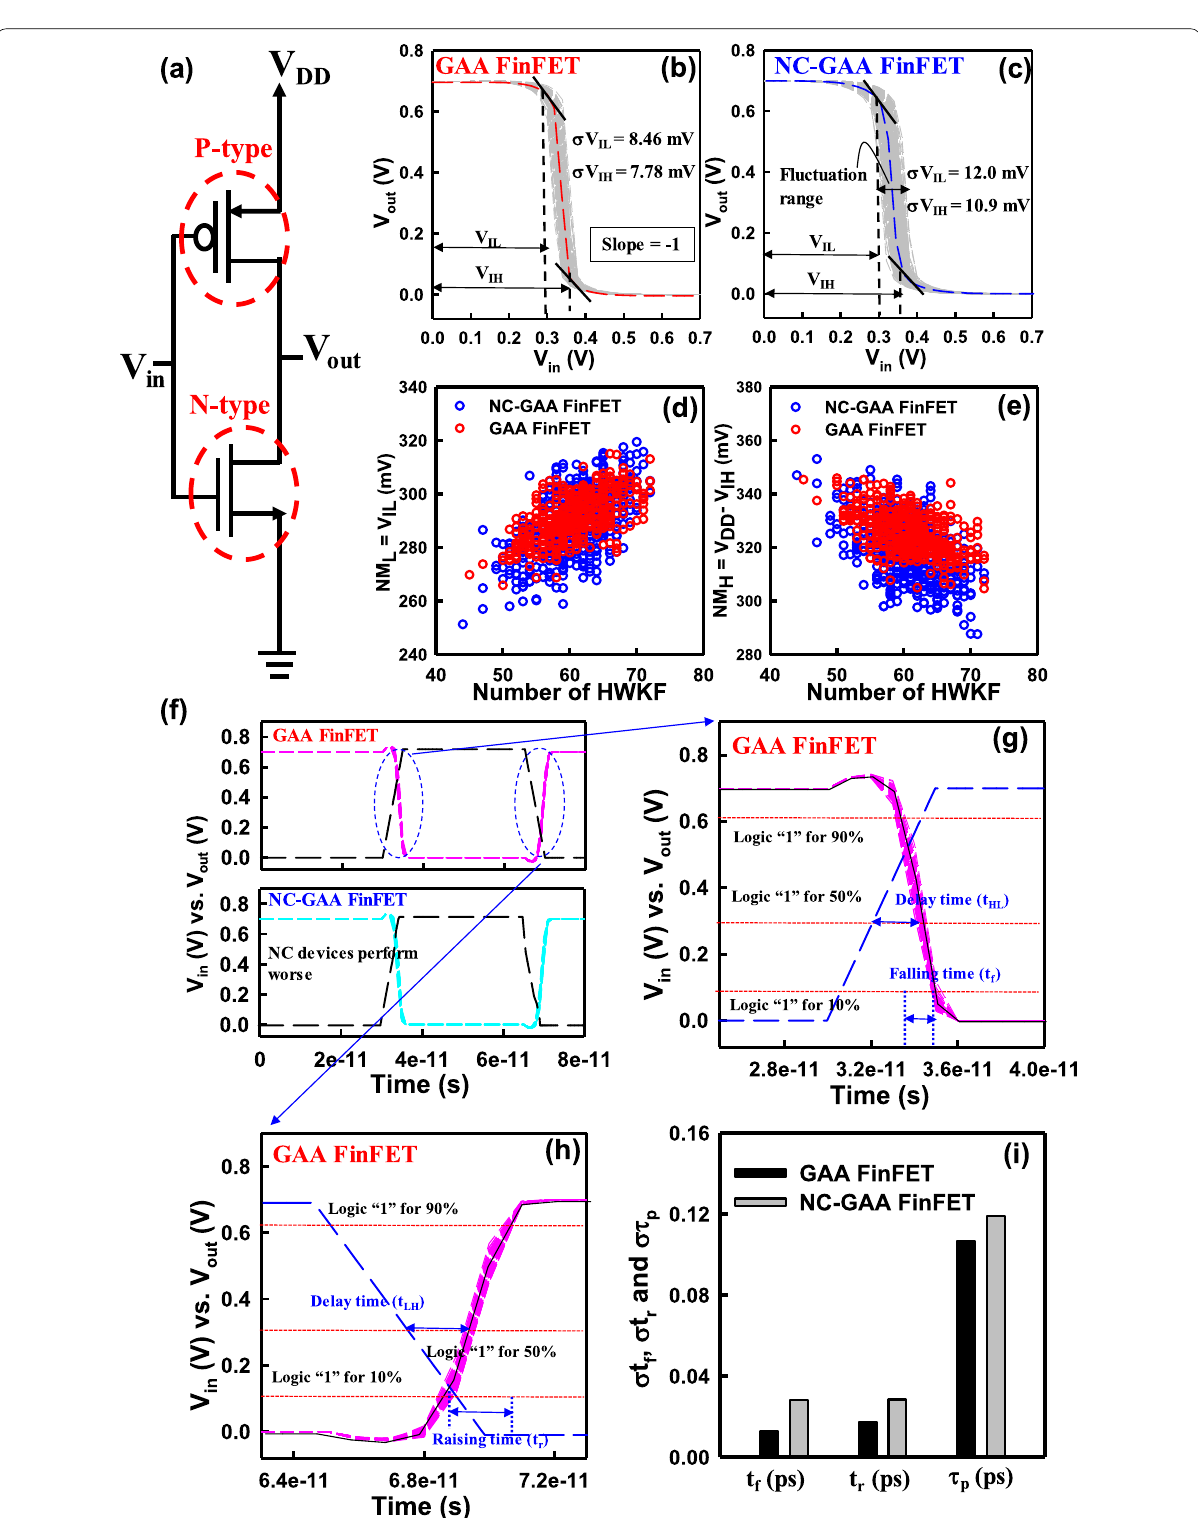
Fig. 12 a The schematic plot of the inverter circuit. The voltage transfer curve for b GAA and c NC‑GAA FinFETs. The NM L and NM H depend on V IL and V IH which are denoted in the plots. The comparison of NM L and NM H for d GAA and e NC‑GAA FinFETs. f The V in and V out versus time for two different devices. The zoom‑in plots which define the characteristics of g t HL and t f and h t LH and t r for GAA FinEETs. i The comparison of σt f , σt r and στ p for GAA and NC‑GAA